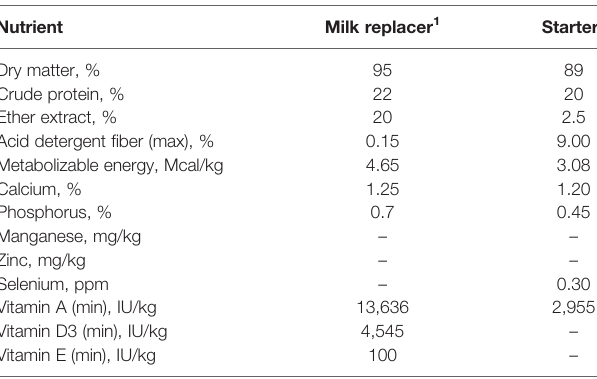
TABLE 1 | The formulated nutrient content of the milk replacer and calf starter fed to pre-weaned Holstein calves. Nutrient Milk replacer